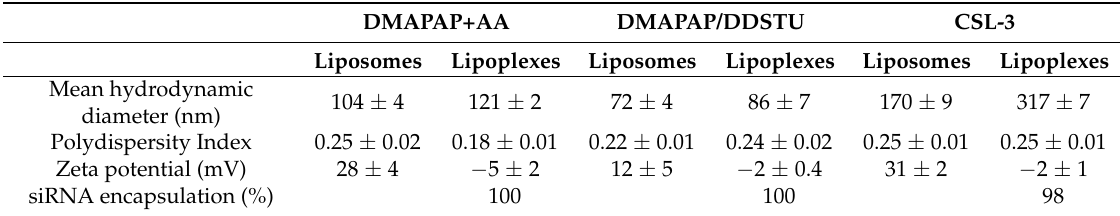
Table 1. Characterization of the liposomes and lipoplexes formulations.